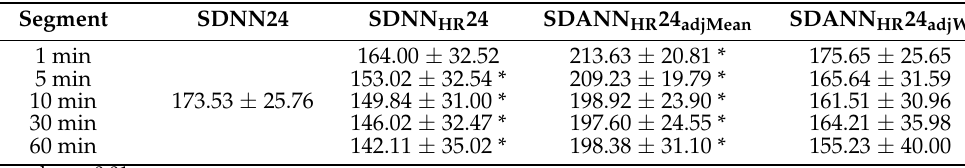
Table 4. Descriptive and statistics analysis of SDNN24 and SDNN24 derived from HR data on mmash dataset. All the values are expressed in milliseconds